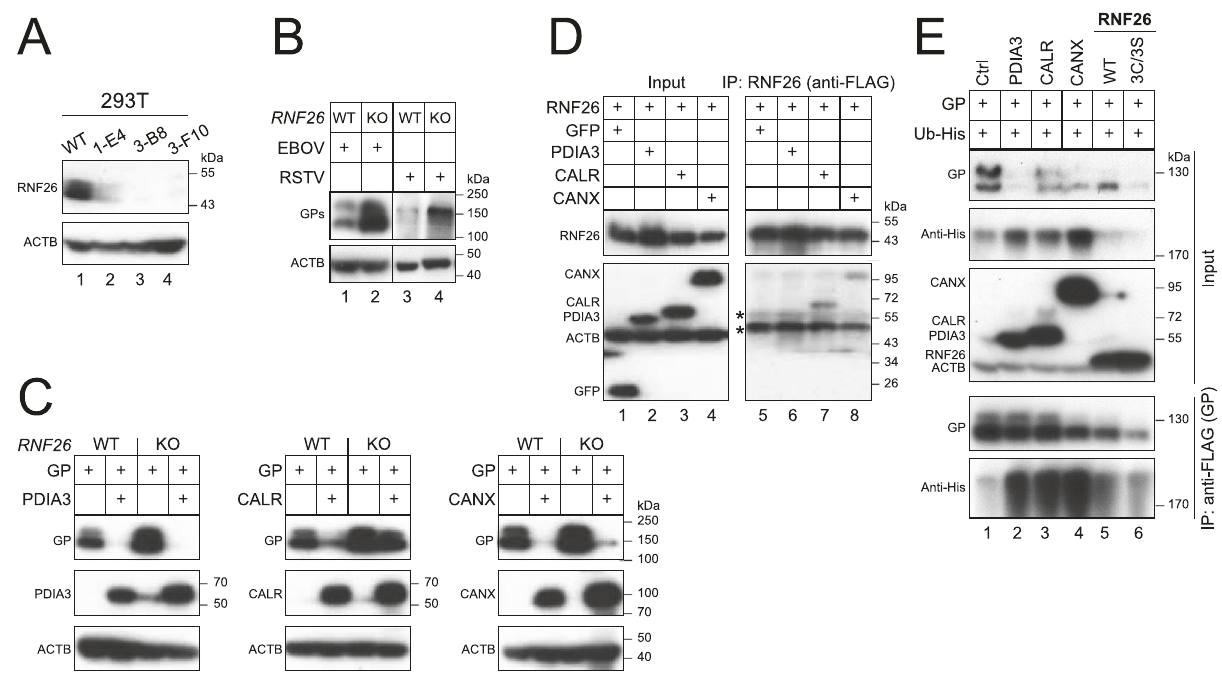
Fig. 6 | RNF26 selectively supports CALR, but not CANX or PDIA3. A Three RNF26 -KO cell lines (1-E4, 3-B8, 3-F10) were generated from HEK293T cells using CRISPR/Cas9. RNF26 expression in these cells was determined by WB using its speci fi cantibody. B EBOV and RSTVGP 1,2 proteins were expressedin HEK293TWT and RNF26 -KO (1-E4) cells. GP expression was detected by WB using anti-EBOV-GP. C EBOV-GP 1,2 (GP) was expressed with PDIA3, CALR, or CANX in HEK293T WT and RNF26 -KO(1-E4) cells. Proteinexpressionwasdetectedby WB.GP wasdetected by anti-EBOV-GP; PDIA3 and CALR were detected by anti-Myc; CANX was detected by anti-HA. D RNF26wasexpressedwithGFP,PDIA3,CALR,orCANXinHEK293Tcells.